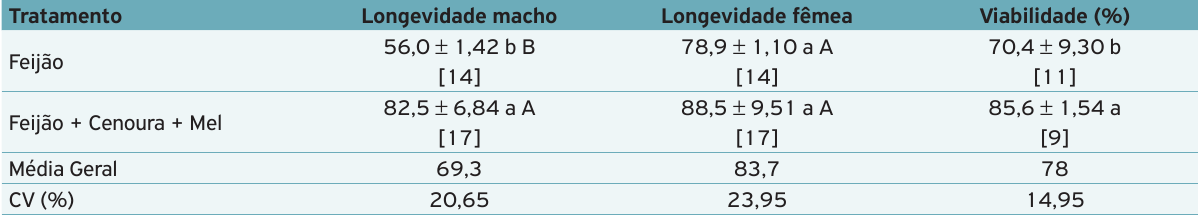
Tabela 2. Longevidade (dias) de machos e fêmeas ± Erro Padrão e viabilidade de ovos de adultos de Diabrotica speciosa alimentados com diferentes dietas em condições